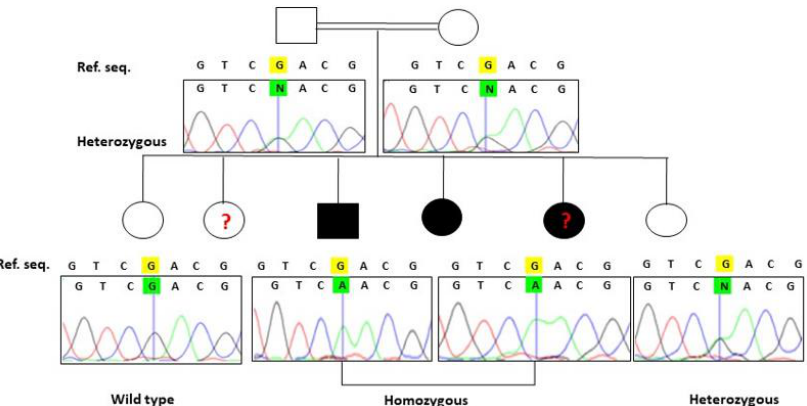
Figure 4. Sanger sequencing demonstrates variant segregation, “?” indicates that DNA were unavailable for analysis, highlighted in yellow ‘G’ is the wildtype nucleotide which is mutated to ‘A’ in patients and heterozygous members of the family.